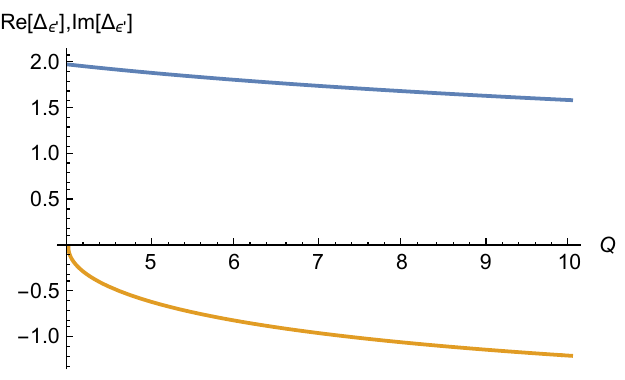
Figure 10: Real and imaginary part of ∆ (cid:34) (cid:48) as a function of Q .